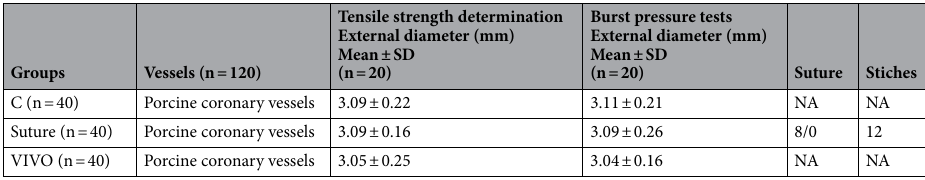
Table 1. General Data of vessels. NA, not applicable.